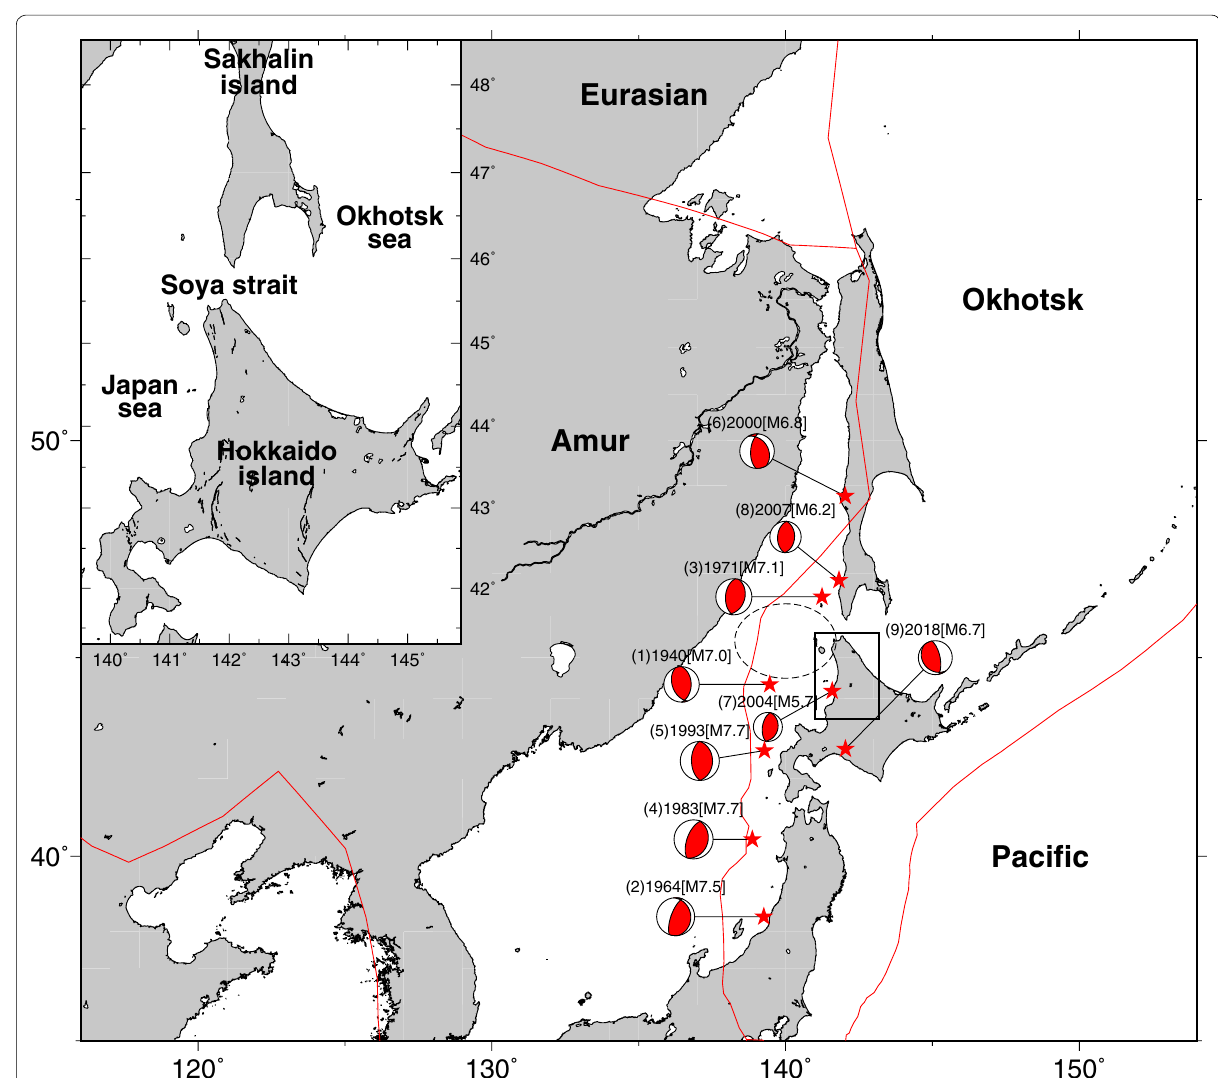
Fig. 1 Tectonic map of northeast Asia. The red line indicates a plate boundary model (PB2002) by Bird (2003). Stars indicate the epicenters of large earthquakes along the eastern margin of the Japan Sea. The moment tensor solutions are from Fukao and Furumoto (1975) for (1) and (3), from Abe (1975) for (2), and from the Global CMT Project (2019) for (4)–(9). A black broken circle indicates the absence of large earthquakes. The study area is indicated by a black solid